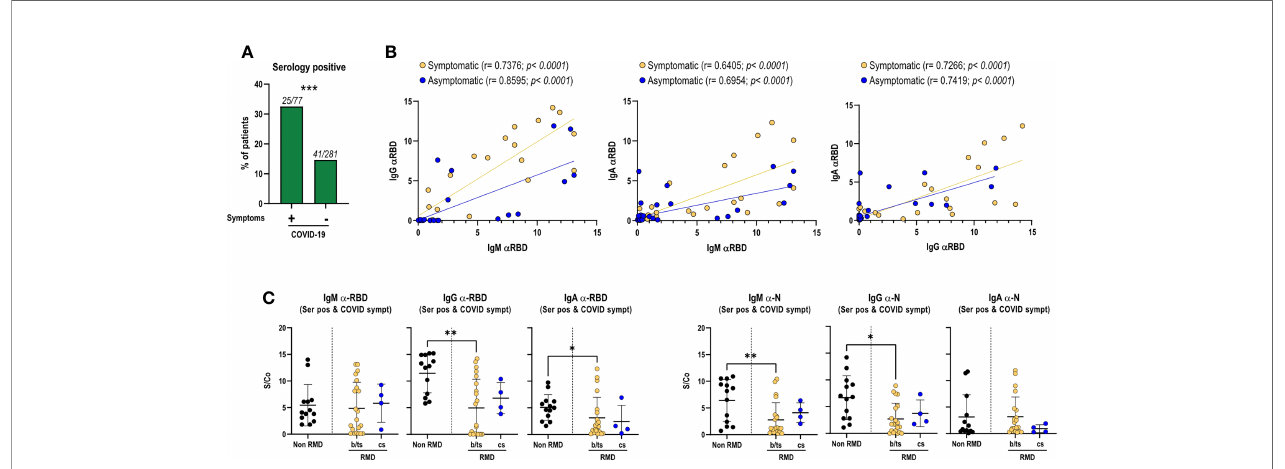
FIGURE 1 | Magnitude of the anti-RBD antibody response in RMD patients, associated with the occurrence of COVID-19 symptoms and treatment categories, as compared to non-RMD individuals. Levels of IgM, IgG, and IgA to SARS-CoV-2 N and RBD measured by ELISA in sera of RMD patients treated with b/ts-DMARD and cs-DMARD and non-RMD individuals who recovered from COVID-19. (A) Frequency of patients symptomatic ( N = 77) and asymptomatic ( N = 281) for COVID-19 that were seropositive to N or RBD proteins. Fisher ’ s exact test was used as statistical analysis. (B) Correlation analysis between anti-RBD IgM/G/A levels in serology- positive COVID-19 symptomatic ( N = 25) and asymptomatic ( N = 41) RMD patients. The p -value and correlation coef fi cient r were calculated using Pearson correlation. (C) Levels of each anti-RBD and anti-N Ig class in serology positive and symptomatic patients ’ groups classi fi ed by DMARD treatment categories. b/ts-DMARD, N = 21; cs-DMARD, N = 4; non-RMD, N = 13. Graphs represent individual values, means, and SD. Statistical signi fi cance was determined using two-tailed Mann – Whitney test. Asterisks denote differences with statistical signi fi cance among groups. Statistical signi fi cance are reported as: * p < 0.05; ** p < 0.01, *** p <